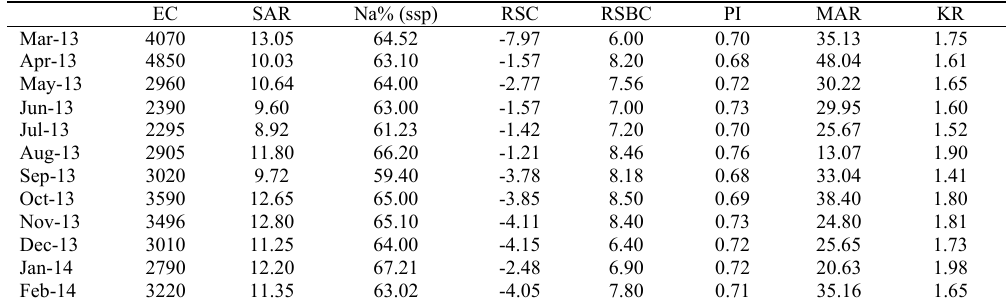
Table 2: Assessment of quality parameters in the TWW from Qom for agricultural purpose EC